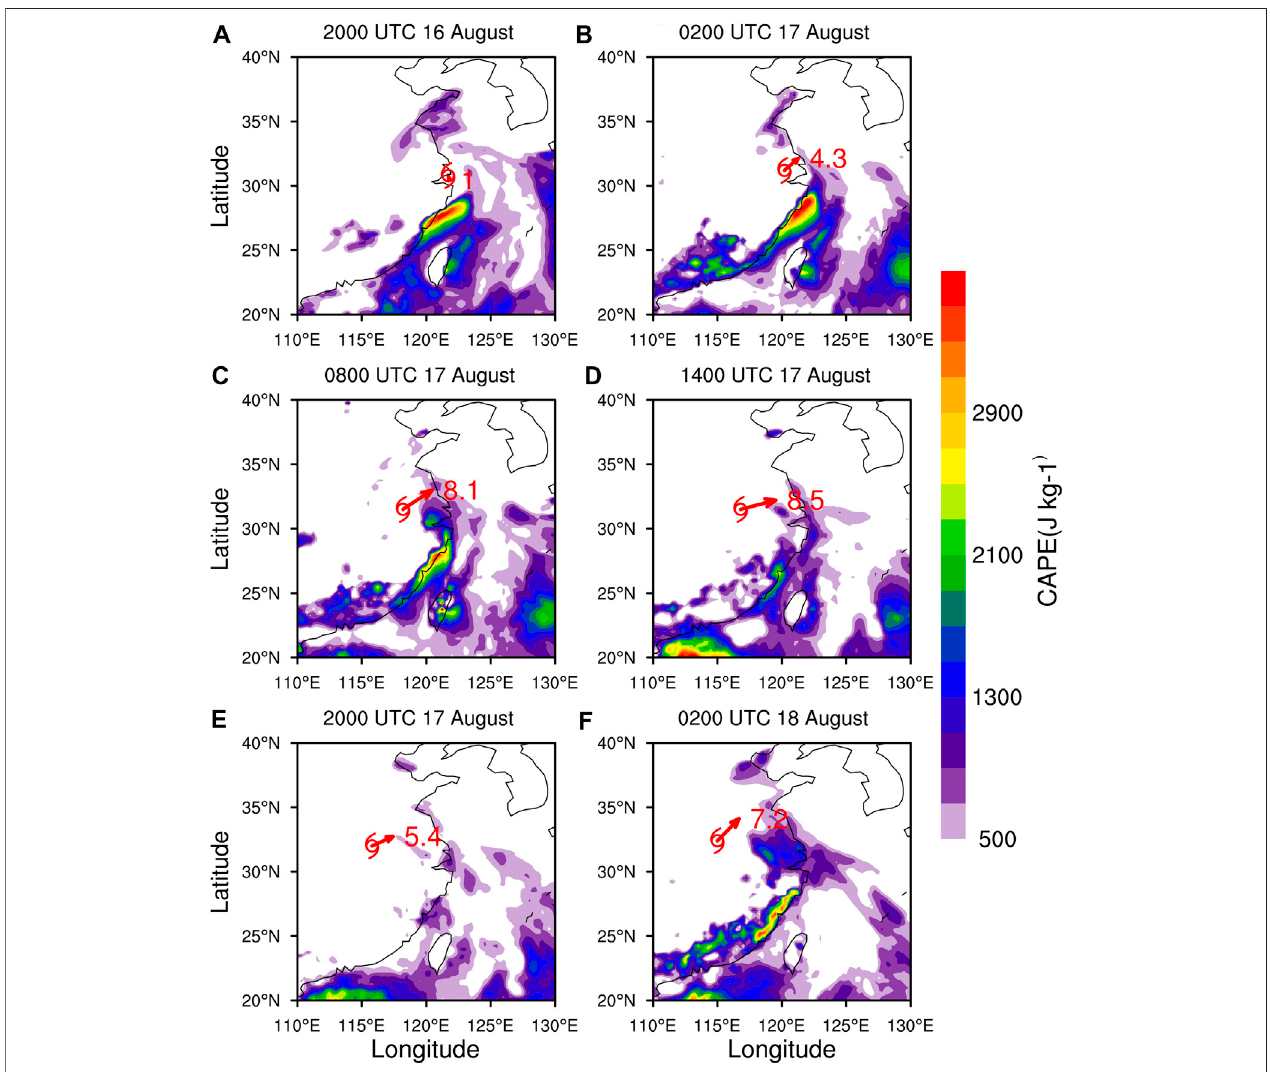
FIGURE10| Convective Available Potential Energy (CAPE, shading, J kg − 1 ) with thedeep layerVWS vectors given at the storm center (redarrows): (A) 2000 UTC 16August, (B) 0200, (C) 0800, (D) 1,400, (E) 2000UTC17August, (F) 0200UTCAugust18,2018.Thecyclonesymbolindicatesthestormcenteratthegiventime.The red arrows and numbers show the 300 – 850 hPa VWS directions and magnitudes (m s − 1 ).